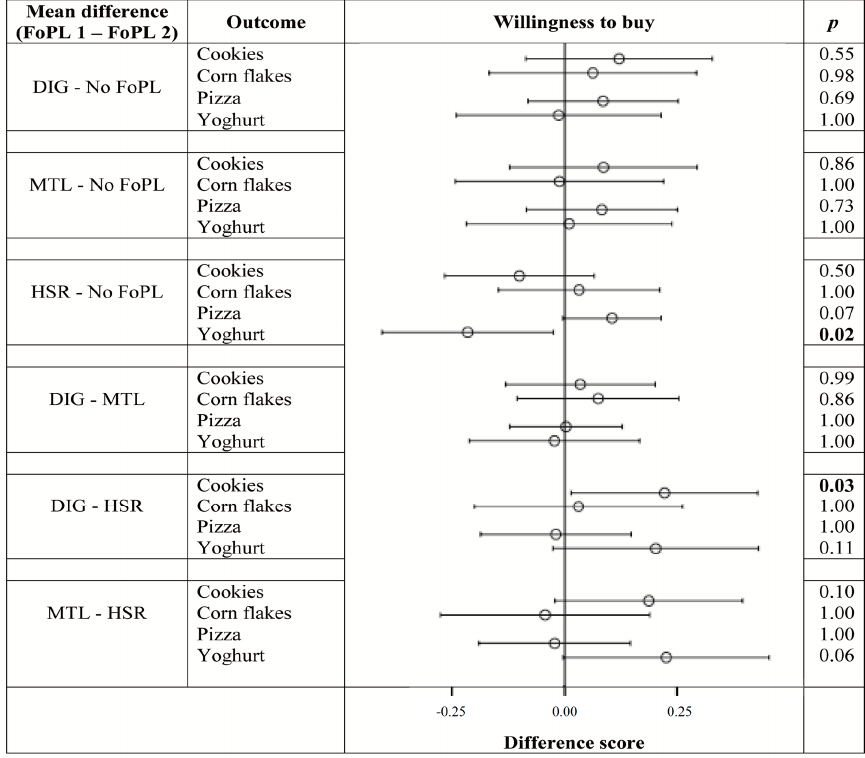
Figure 5. Difference in ratings between FoPLs ( (cid:9) ) and the upper ( (cid:96) ) and lower ( (cid:97) ) bounds of 95% confidence intervals for willingness to buy according to food